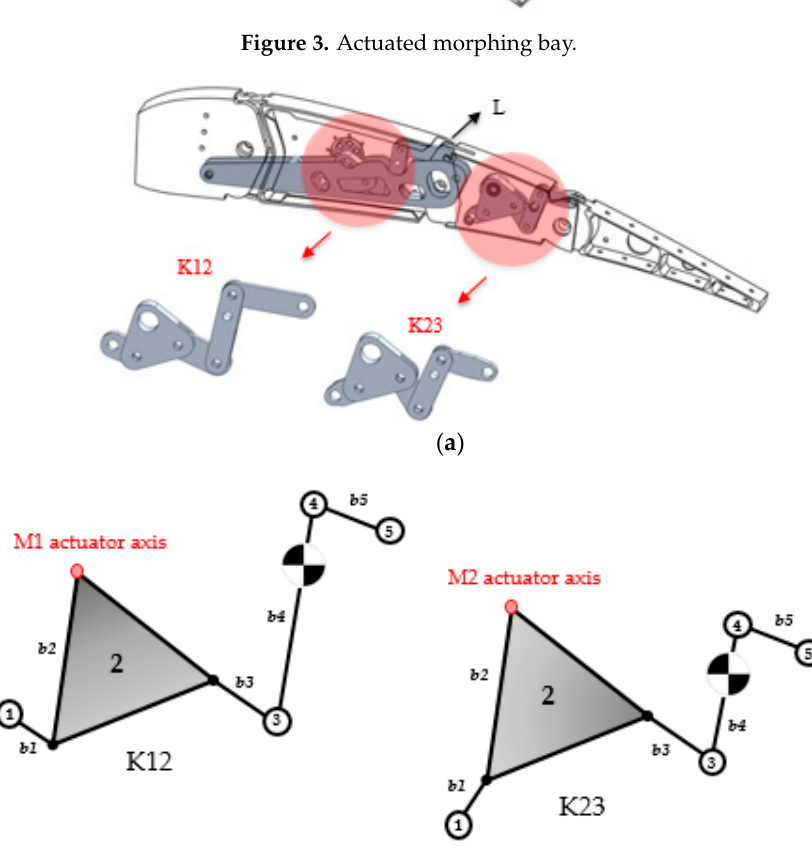
Figure 3. Actuated morphing bay.